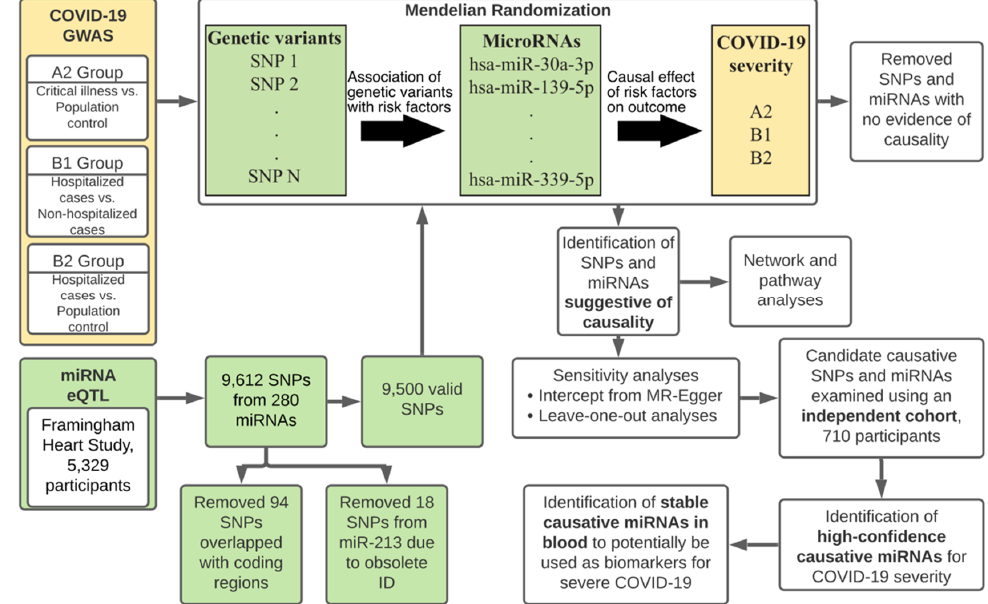
Figure 1. Flowchart of the study design. Green boxes show the processes related to risk factor (miRNAs) and yellow boxes show the processes related to outcome (COVID-19).